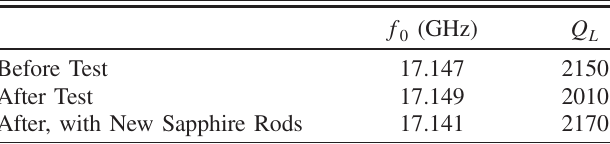
TABLE VI. Comparison of the resonant frequency f 0 and the quality factor Q L of the HPBG-d3 structure before and after the high power